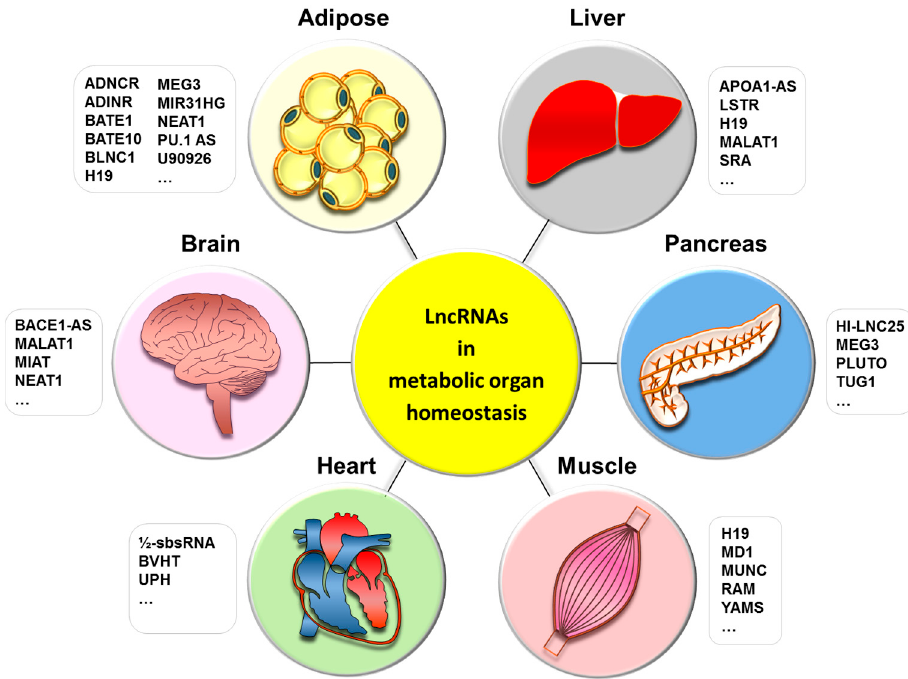
Figure 1. LncRNAs in metabolic organ homeostasis. This figure represents the metabolic organs implicated in energy homeostasis and their associated lncRNAs; in liver: lncRNA APOA1-AS, lncRNA H19, lncRNA LSTR, lncRNA MALAT1, lncRNA SRA; in pancreas: lncRNA HI-LNC25, lncRNA MEG3, lncRNA PLUTO, lncRNA TUG1; in skeletal muscle: lncRNA H19, lncRNA MD1, lncRNA RAM, lncRNA YAM-1; in heart: lncRNA 1/2-sbsRNA B2, lncRNA BVHRT, lncRNA UPH; in brain: lncRNA BACE1-AS, lncRNA MALAT1, lncRNA MIAT, lncRNA NEAT1; in adipose tissue: lncRNA ADINR, lncRNA ADNCR, lncRNA BATE1, lncRNA BATE10, lncRNA BLNC1, lncRNA H19, lncRNA MEG3, lncRNA MIR31HG, lncRNA NEAT1, lncRNA PU.1 AS, lncRNA U90926.